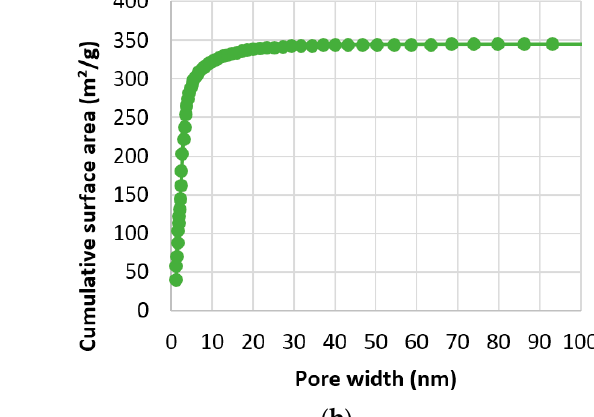
Figure 4. FTIR spectra of activated carbon from argan nutshells.